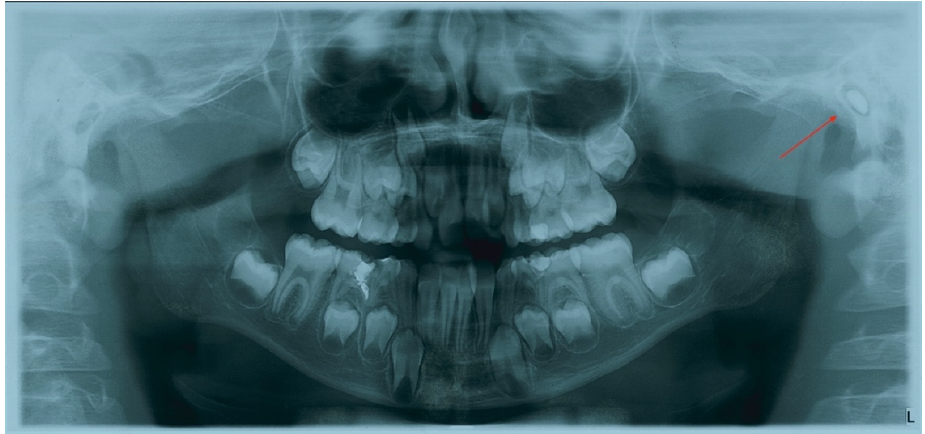
Figure 2. Orthopantomography showing foreign body in the left external auditory canal.